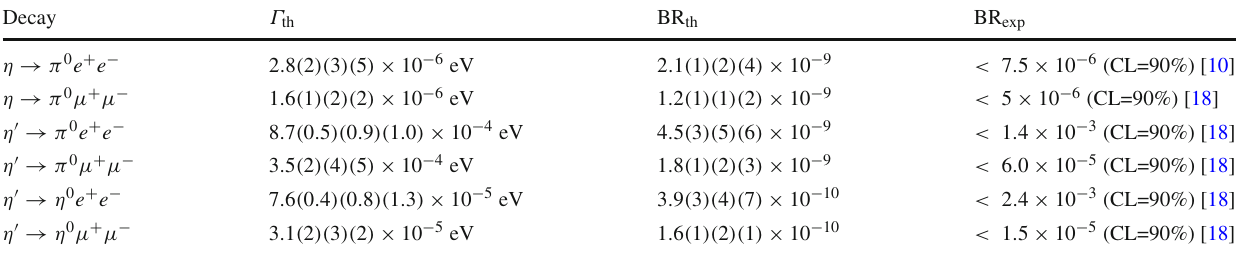
Table 1 Decay widths and branching ratios for the six C -conserving decays η ( (cid:2) ) → π 0 l + l − and η (cid:2) → η l + l − ( l = e or μ ). First error is experimental, second is down to numerical integration and third is due to model dependency Decay Γ th BR